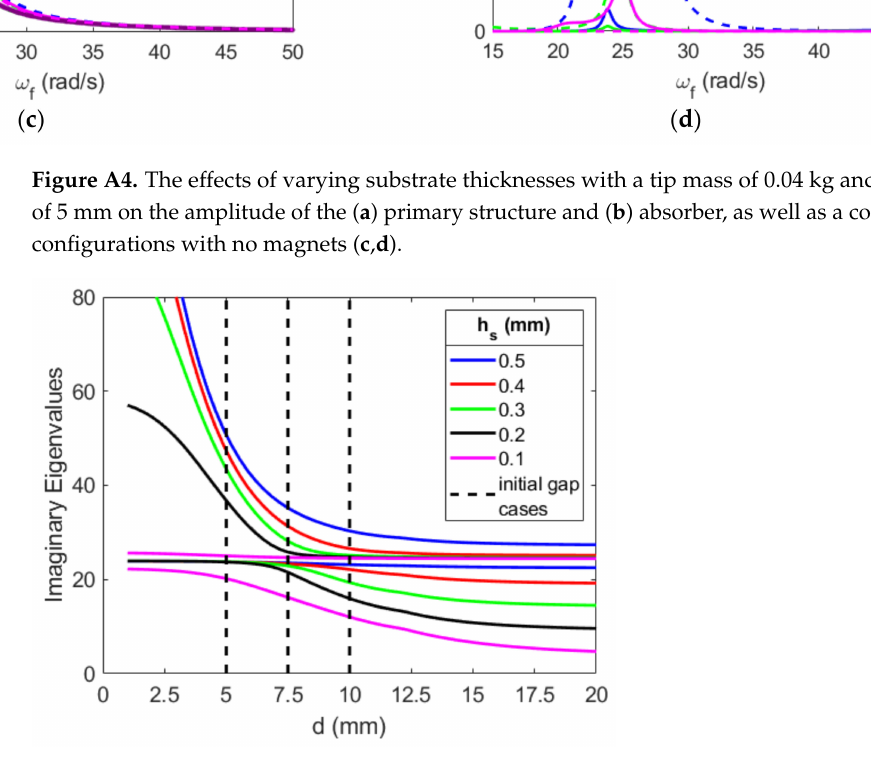
Figure A5. The initial gap’s effects on the coupled natural frequencies for varying substrate